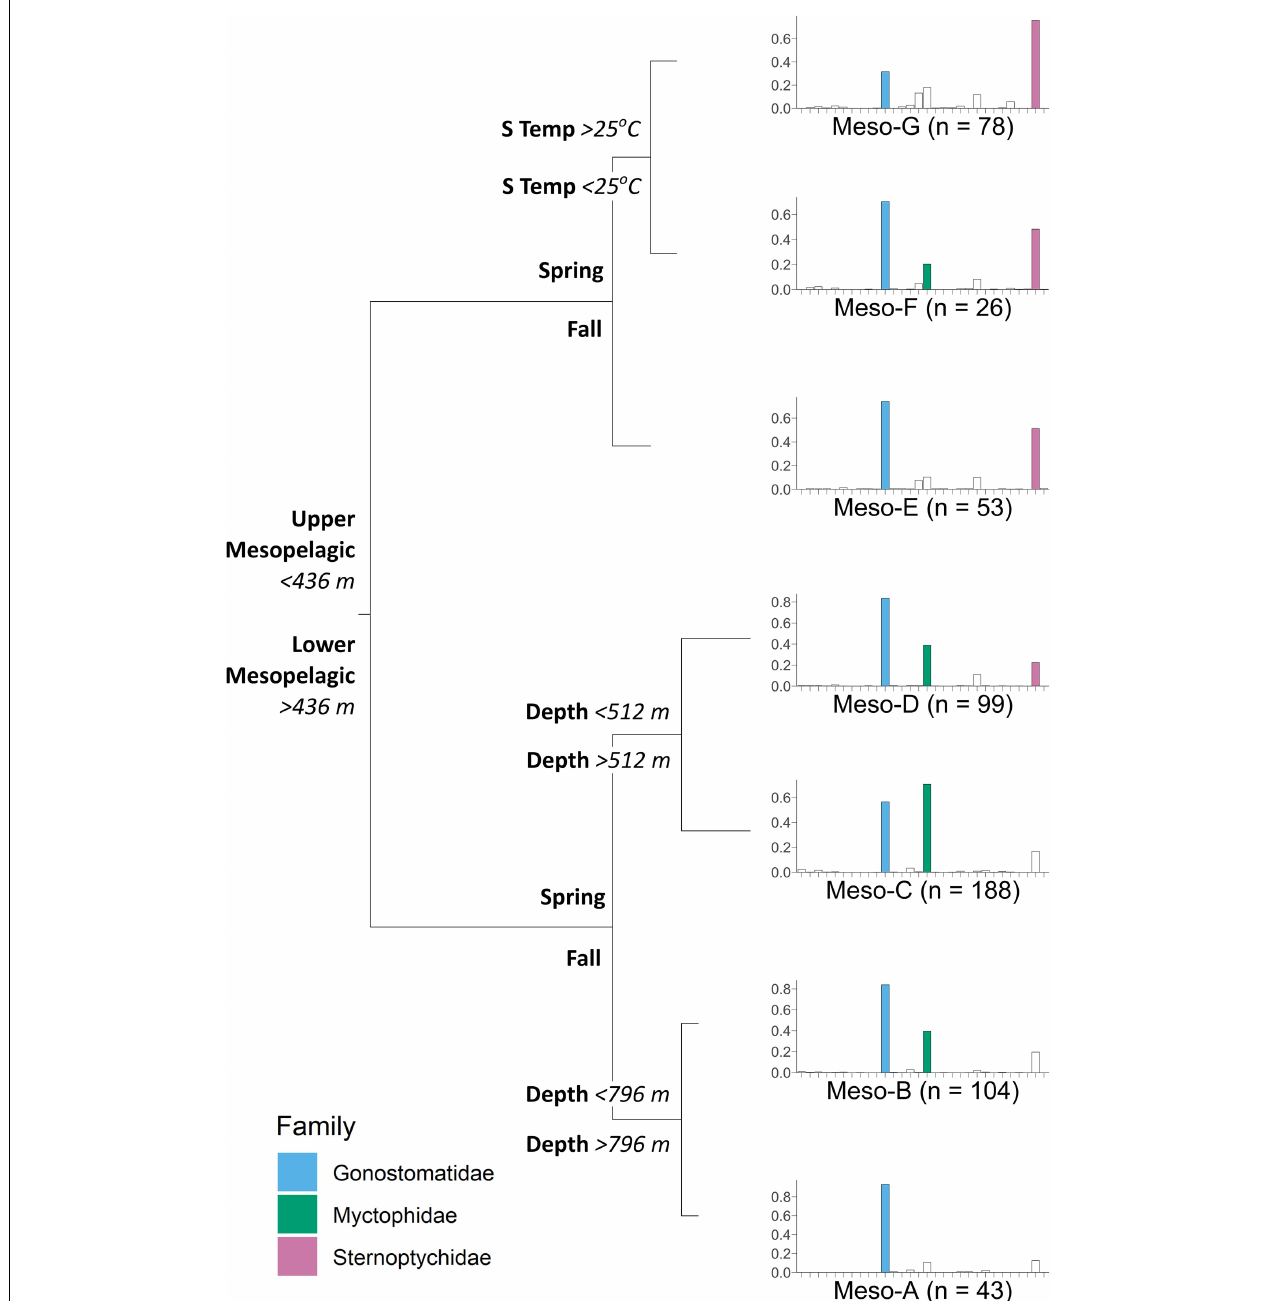
FIGURE 5 | Multivariate regression tree illustrating the effect of depth, season (fall/spring), and surface temperature (S Temp) on the structure of mesopelagic (200–1,000 m) larval fish assemblages in the northern Gulf of Mexico. Each node represents a diverging environmental or spatiotemporal variable, resulting in terminal nodes with distinct assemblage groups (Meso-A – Meso-G). Barplots represent mean square root relative abundance (i.e., Hellinger-transformed larval abundance; y -axis) for each of 30 families ( x -axis) in alphabetical order from left to right (see Table 2 for list of family names), with the most abundant families (abundance > 0.2) in each assemblage group highlighted in color for clarity. Sample size (n) for each assemblage group is indicated next to the group name.